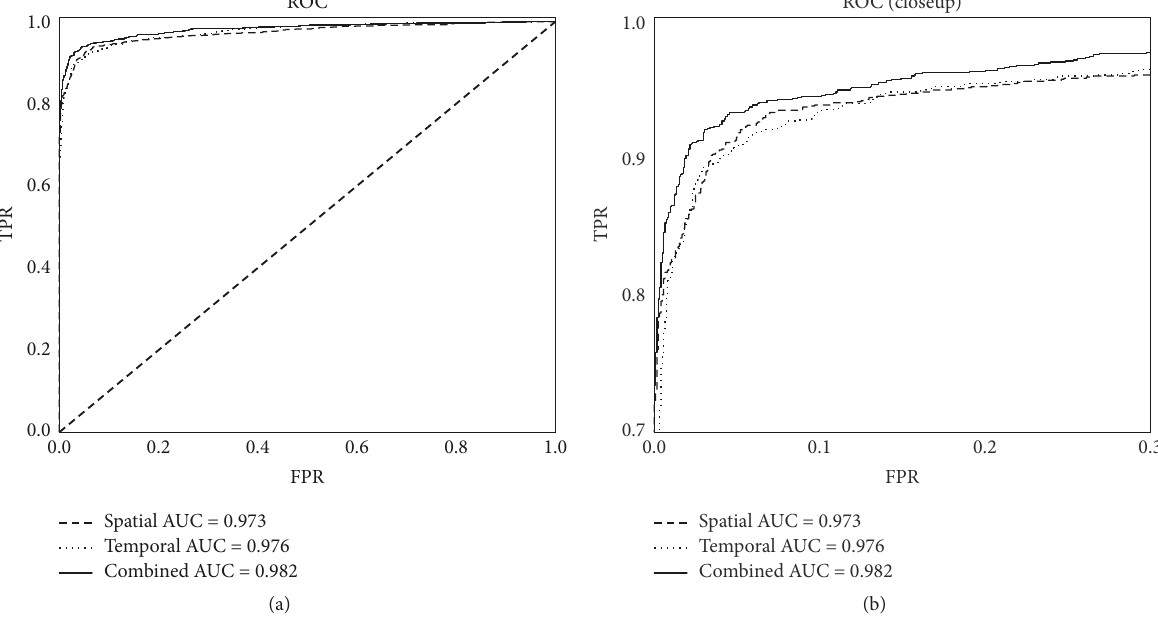
Figure 7: Receiver operator characteristics (ROC) are shown separately for the spatial and temporal branch and the combined model as implemented in DCNN. The ROC curves show the sensitivity (true positive rate, TPR) against the fallout (false positive rate, FPR) for various thresholds. (a) Total view on the ROC curves in comparison to a totally random classification (dashed line). (b) The close-up of the ROC curves highlights the differences in model